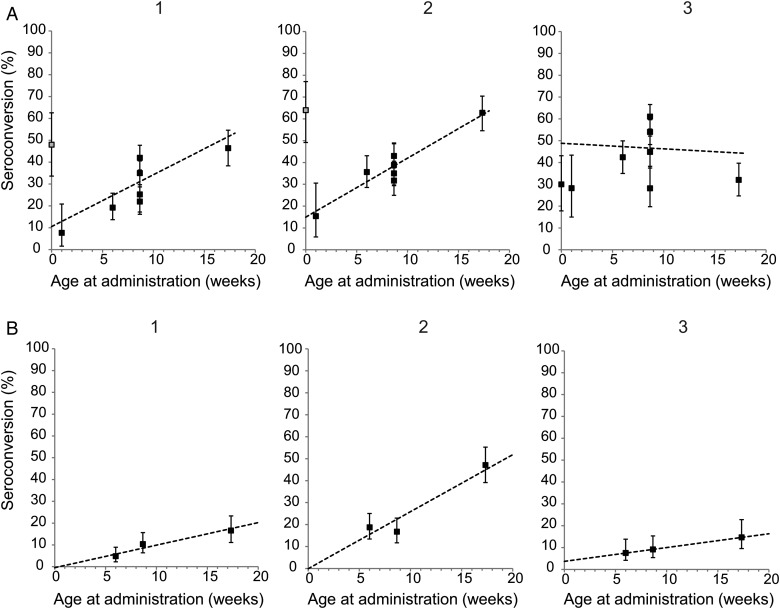
Proportion of children seroconverting to each serotype after 1 dose of inactivated poliovirus vaccine (IPV), plotted against age at administration. A, Full-potency IPV given intramuscularly. B, Fractional (1/5) dose IPV given intradermally using a needle-free device. The dashed line shows the maximum-likelihood linear trend (likelihood ratio test for trend P <.001, <.001, and .49 for serotypes 1, 2, and 3 in A, and P <.001, <.001, and .027, respectively, in B). The error bars show the 95% confidence intervals for the data. Seroconversion was defined in each study as either a 4-fold rise in neutralizing antibody titer compared with that expected based on the expected decline in maternal antibodies, or detection of neutralizing antibodies in children previously seronegative (see Supplementary Table 1 for details for each study). Seroconversion data from a study of IPV given at birth in India is shown with a gray fill for serotypes 1 and 2 (A), as a high proportion of infants showed seroconversion to these serotypes in the control arm of the study where IPV was not administered at birth [8]. Data from this study for serotypes 1 and 2 were therefore not included when estimating the best-fit linear trend.